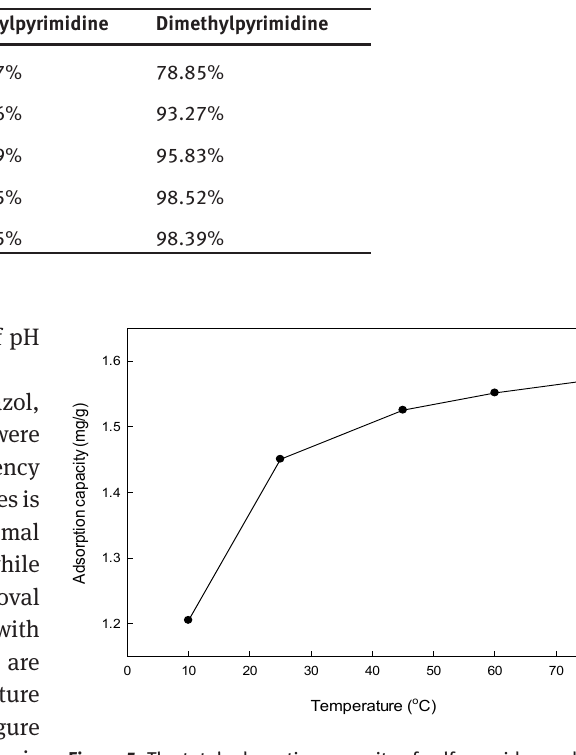
Figure 5: The total adsorption capacity of sulfonamides under different